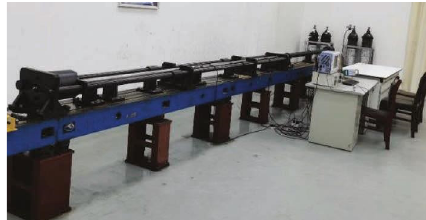
Figure 3: SHPB experimental